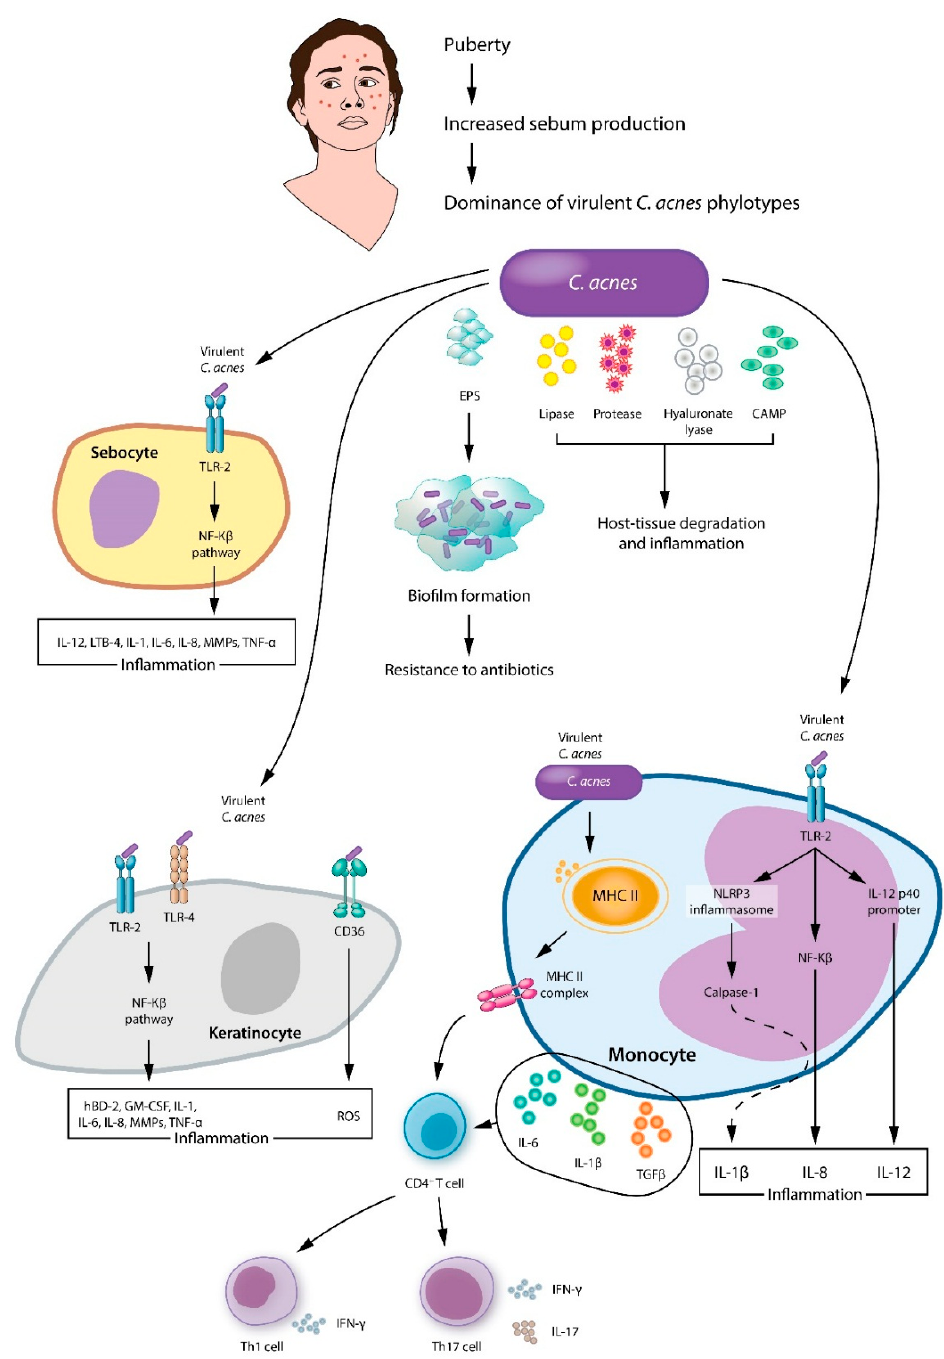
Figure 4. A proposed model of main pathologic processes induced by C. acnes involve sebocytes, keratinocytes, and monocytes in acne vulgaris. EPS: extracellular polymeric substances; CAMP: cyclic adenosine monophosphate; TLR: toll like receptor; IL: interleukin; TNF: tumor necrosis factor; LTB: leukotriene B; CD36: cluster of differentiation 36; GM-CSF: granulocyte-macrophage colony stimulating factor; hBD: human β -defensin; MMPs: matrix metalloproteinases.